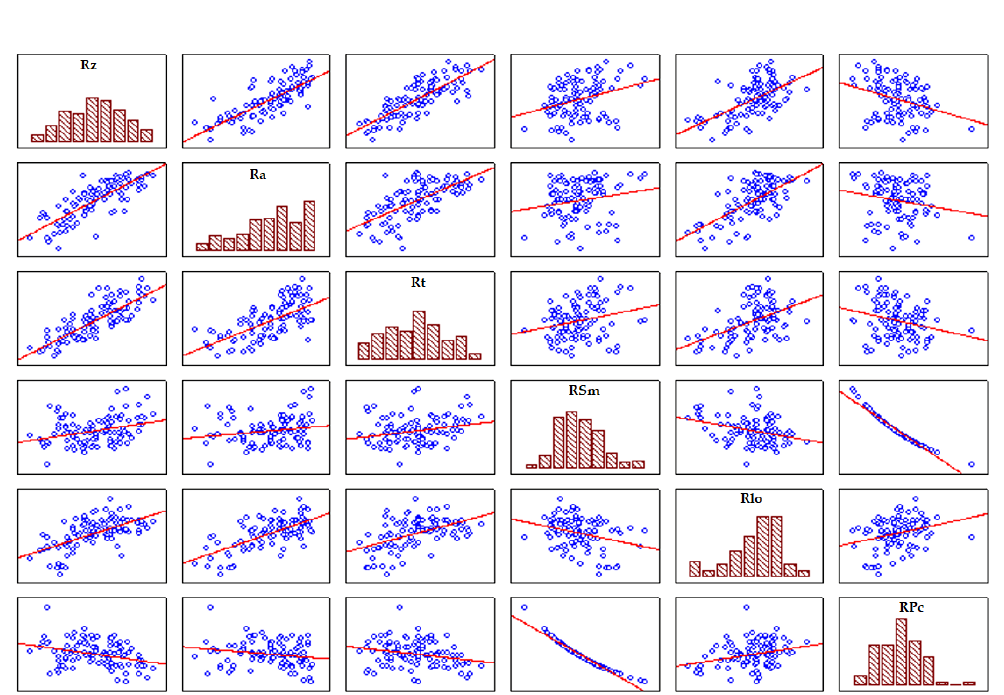
Figure 10. The correlation matrix and the graphs for the corundum. Correlation matrix and graphs of demetalized steelmaking slag (Figure 11) show a statistically significant correlation between the monitored parameters except for Rlo-RSm and Rlo-RPc. There is a very close dependence between RPc-RSm. Rz-Ra and Rz-Rt feature a high dependence. Parameters Rz-Ra and Rz-Rt feature a strong direct dependence and a strong indirect dependence exists between RPc-RSm. There is an indirect dependence between RPC and other